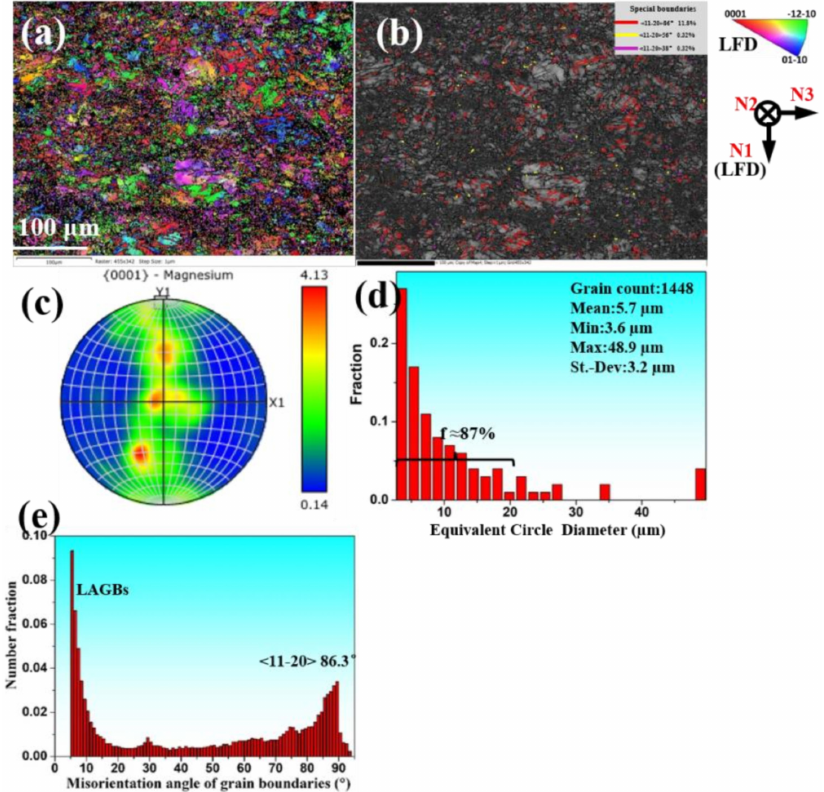
Figure 4. ( a ) Inverse pole figure map, ( b ) band contrast map, ( c ) {0001} pole figure, ( d ) grain size distribution histogram, and ( e ) misorientation angle of grain boundaries of MDIF100+100 sample of GW52 alloy at the center location (~35